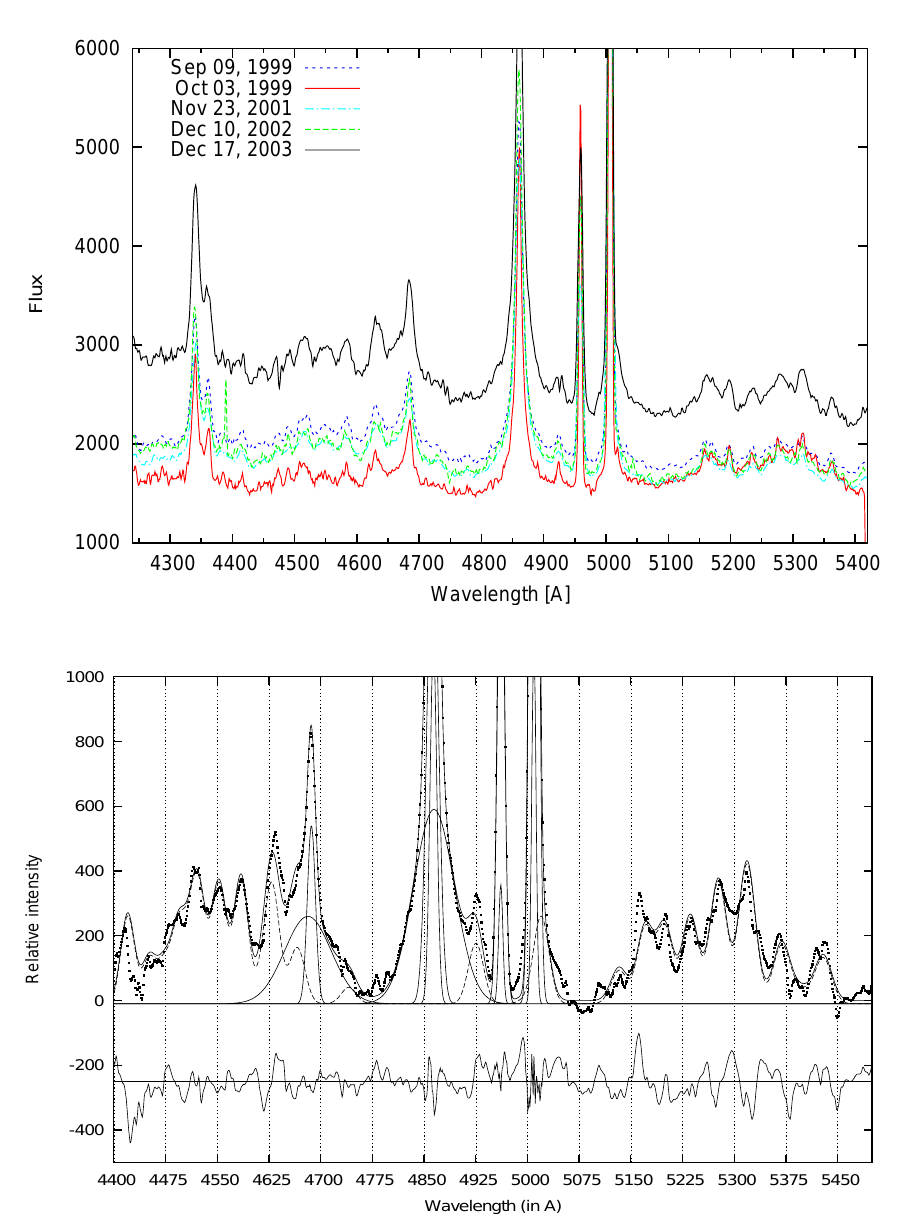
Fig. 1. Upper panel: the (cid:13)ux variability of Ark 564. Dates are given in the insert. Lower panel: an example of the spectrum of Ark 564 (cid:12)tted to the Gaussian components for all